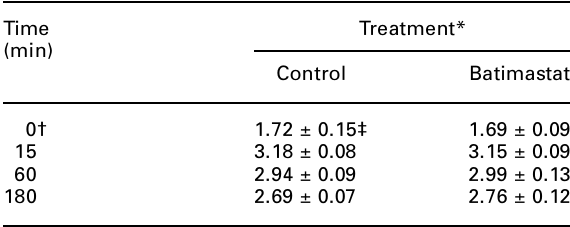
Table 1. Lack of inhibition of edema-forming activity of MT-III by pretreatment with the MMP inhibitor batimastat Time (min)